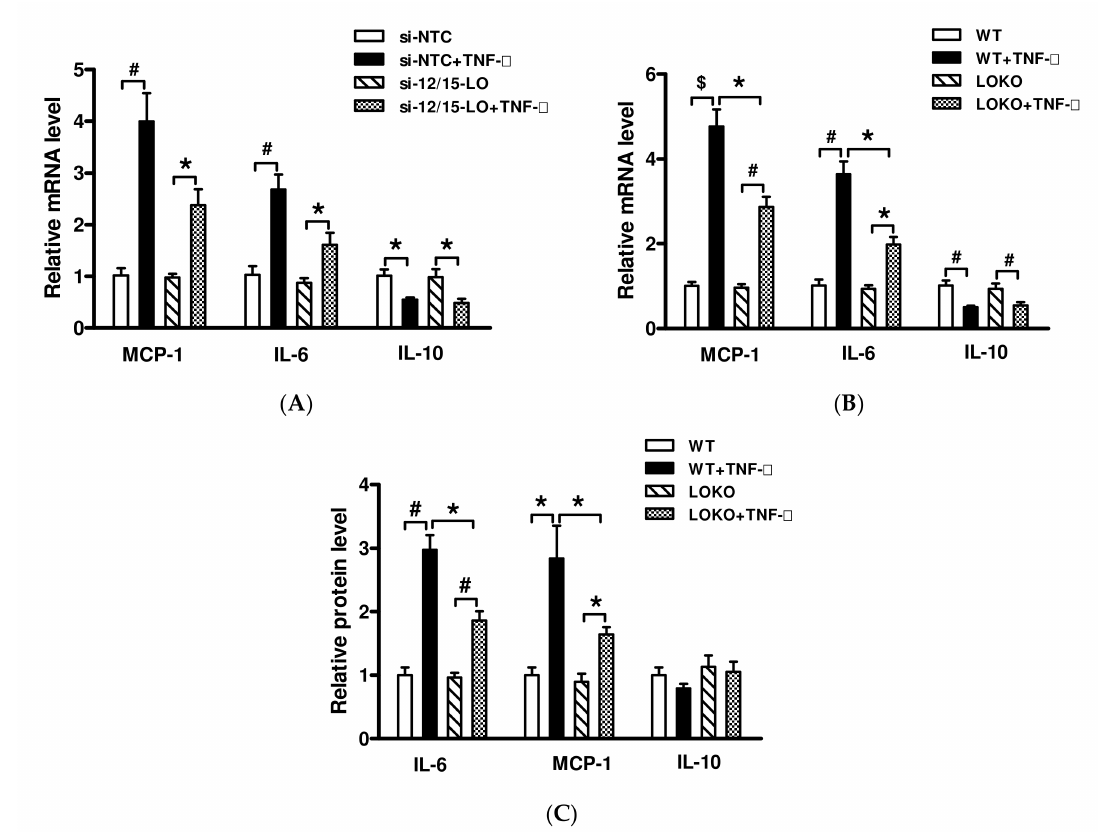
Figure 3. Specific 12/15-LO siRNA transfection or gene knockout attenuated TNF- α induced in- flammatory genes expression. ( A ) MCs were transfected with siRNA targeting 12/15-LO or siNTC oligonucleotides; after 48 h, transfected MCs were serum depletion (SD) for 24 h, and then treated with TNF- α (10 ng/mL) for another 2 h. Expression of inflammatory genes was detected by RT-qPCR. The results are shown as fold over siNTC (mean ± SEM, n = 3. * p < 0.05, # p < 0.01 vs. siNTC or si12/15-LO). ( B ) MCs from WT and LOKO mice were SD for 24 h, and then treated with TNF- α (10 ng/mL) for 2 h. Expression of MCP-1, IL-6 and IL-10 was detected by RT-qPCR. ( C ) Equal numbers of sub-confluent MCs from WT and LOKO mice were cultured in the medium (RPMI1640 + 1%FBS) containing either buffer (control) or TNF- α (10 ng/mL) for 24 h. An aliquot supernatant was collected from each well and the contents of IL-6, MCP-1, and IL-10 were measured by ELISA kits. The results are expressed as fold over WT control (mean ± SEM, n = 3. * p < 0.05, # p < 0.01, $ p < 0.001 vs.